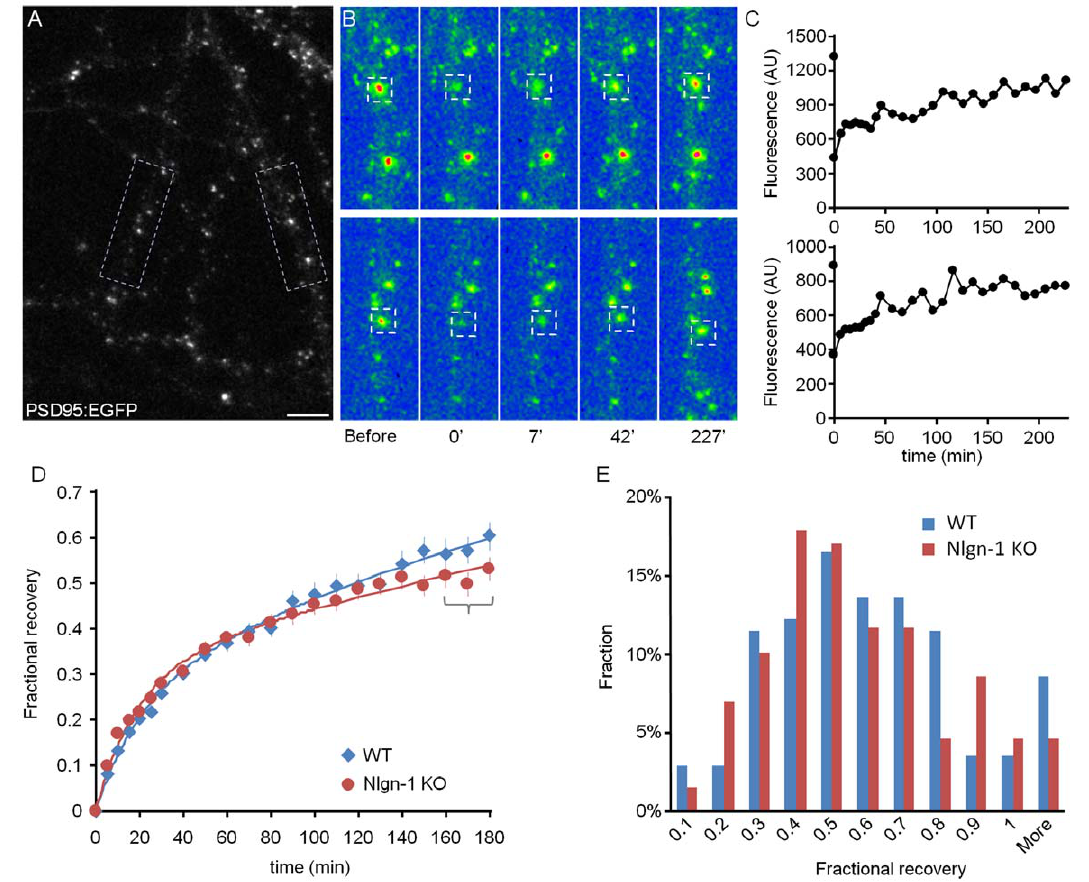
Figure 2. Exchange rates of PSD-95:EGFP at individual synapses. A ) Dendrites of a neuron from a WT mouse expressing PSD-95:EGFP. Two PSD-95:EGFP puncta, one in each rectangular region, were selected for photobleaching. Bar, 10 m m. B ) The two puncta (enclosed in squares) were selectively photobleached by high intensity laser light and fluorescence recovery at these sites was subsequently followed by time-lapse imaging. Fluorescence intensities shown in false color. C ) Fluorescence recovery time course for the two photobleached puncta shown in A and B. D ) Average FRAP curves for synapses from Nlgn-1 KO (13 neurons, 129 synapses) and WT littermates (13 neurons, 140 synapses; Mean 6 SEM). Fits to sums of two exponentials (see Results) are shown as thick lines. E ) Distribution of fractional recovery values for all photobleached PSD-95:EGFP puncta. The fractional recovery of each punctum was calculated as the average value of the 3 last points of its normalized recovery curve (as indicated by curly bracket in D).